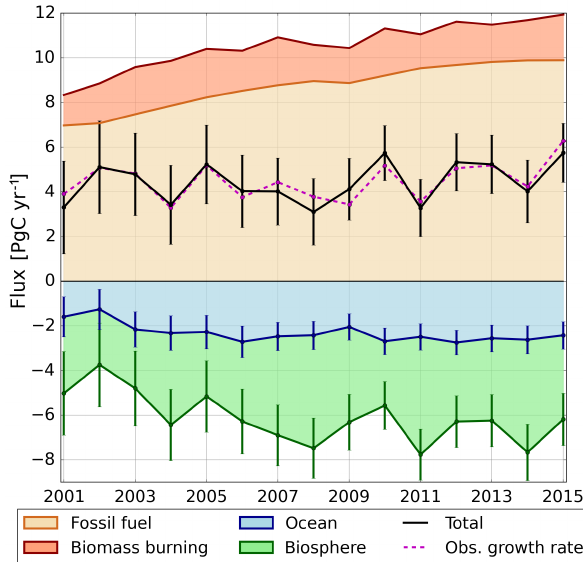
Figure 3. Global annual carbon balance estimated with CTE2016 for the period 2001–2015. Global ocean (blue) and biosphere (green) sinks are indicated as negative values and represent net uptake from the atmosphere. The error bars represent the annual 1 σ uncertainty, based on the average weekly covariances (more information on the error estimates in CarbonTracker in given in Sect. 3.4). Fossil fuel (orange) and biomass burning (red) emissions are not optimized. The total flux (black line) is the sum of the four components. The observed global annual atmospheric CO 2 growth rate from the NOAA network (dashed magenta line) was con- verted from ppmyr − 1 using a conversion factor of 2.12PgCppm − 1 (Prather et al., 2012).